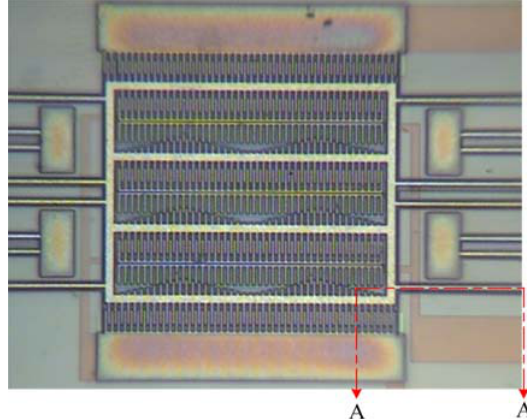
Figure 9. Optical image of the tunable resonator after completion of the CMOS process.